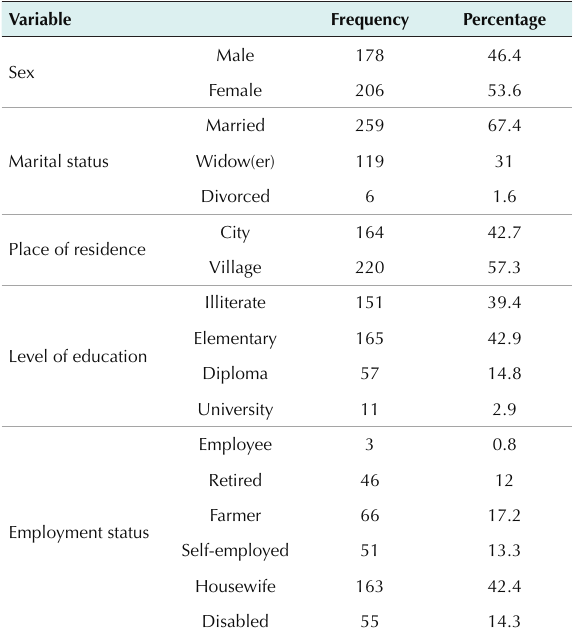
Table 1 . Demographic Information of Research Subjects Variable